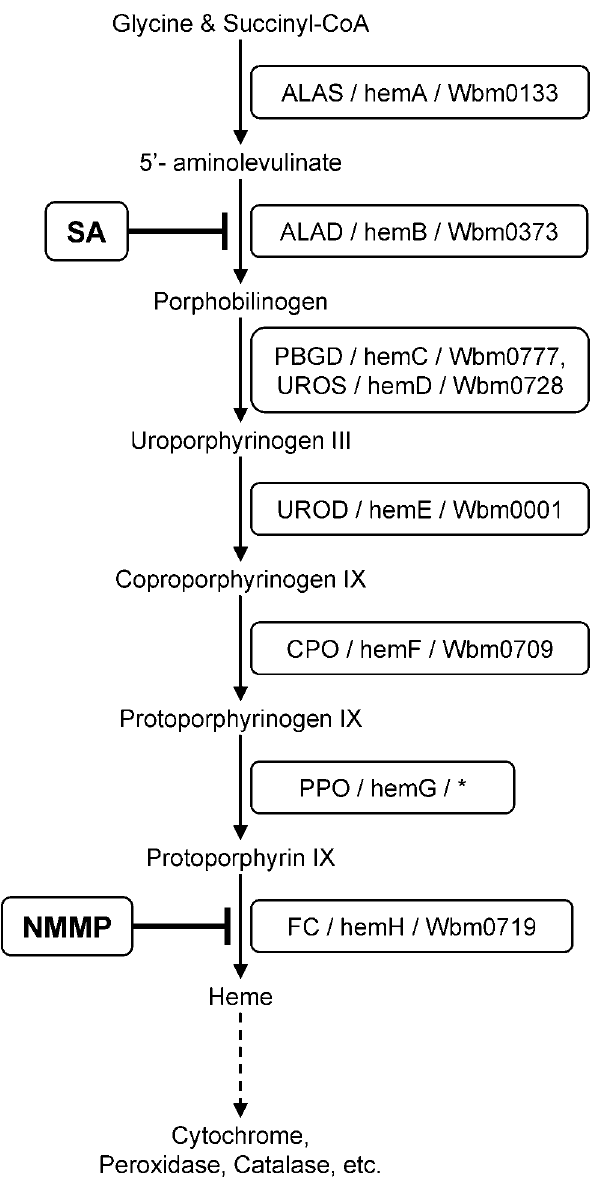
Figure 1. Schematic diagram of the heme biosynthetic pathway. The text in the boxes indicates the eukaryotic/prokaryotic/ Wolbachia gene name. The asterisk indicates the gene missing in Wolbachia genome (PPO). ALAS, 5-aminolevulinate synthase (EC 2.3.1.37); ALAD, 5-aminolevulinate dehydratase (also known as PBGS, porphobilinogen synthase, EC 4.2.1.24); PBGD, porphobilinogen deam- inase (EC 4.1.3.8); UROS, uroporphyrinogen-III synthase (EC 4.2.1.75); UROD, uroporphyrinogen-III decarboxylase (EC 4.1.1.37); CPO, copro- porphyrinogen-IX oxidase (EC 1.11.1.10); PPO, protoporphyrinogen-IX oxidase (EC 1.3.3.4); FC, ferrochelatase (EC 4.99.1.1); SA, ALAD inhibitor Succinyl acetone; NMMP, FC inhibitor N-methyl mesoporphyrin.